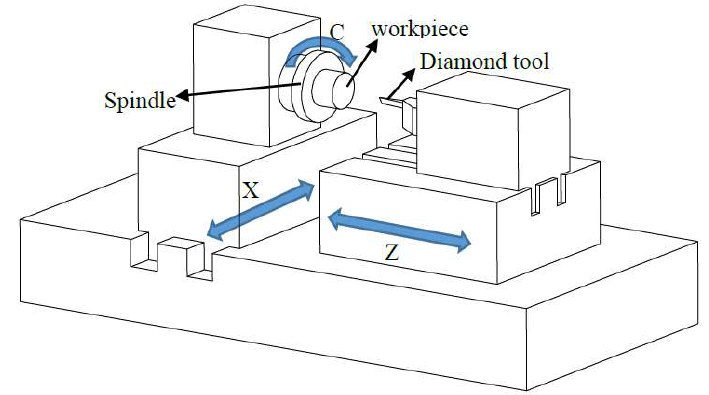
Figure 5. Configuration of the machining system.